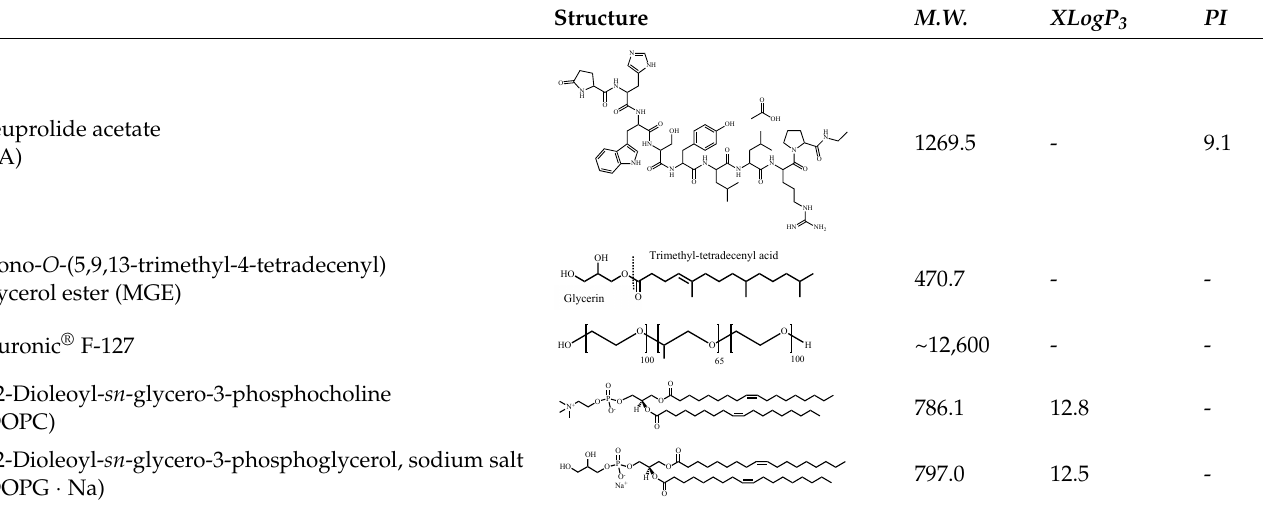
2.2. Methods 2.2. Methods 2.2.1. Preparation of Lipid Particles 2.2. Methods 2.2.1. Preparation of Lipid Particles DOPC and DOPG with a molar ratio of 25:75 at 1.0 mM total lipid concentration were 2.2. Methods 2.2.1. Preparation of Lipid Particles DOPC and DOPG with a molar ratio of 25:75 at 1.0 mM total lipid concentration were dissolved in ethanol in a flask, then evaporated at 50 °C to obtain a thin lipid layer. This 2.2.1. Preparation of Lipid Particles dissolved in ethanol in a flask, then evaporated at 50 °C to obtain a thin lipid layer. This ratio was chosen based on a preliminary study with different molar ratios of DOPC and DOPC and DOPG with a molar ratio of 25:75 at 1.0 mM total lipid concentration were DOPC and DOPG with a molar ratio of 25:75 at 1.0 mM total lipid concentration were ratio was chosen based on a preliminary study with different molar ratios of DOPC and DOPG (100:0, 75:25, 55: 45, 25:75) because it gave a small particle size with a small poly- dissolved in ethanol in a flask, then evaporated at 50 °C to obtain a thin lipid layer. This dissolved in ethanol in a flask, then evaporated at 50 °C to obtain a thin lipid layer. This DOPG (100:0, 75:25, 55: 45, 25:75) because it gave a small particle size with a small poly- dispersity index value (PDI) (Figure S1). Next, MGE: Pluronic ® F-127: DOPG was dis- ratio was chosen based on a preliminary study with different molar ratios of DOPC and DOPC and DOPG with a molar ratio of 25:75 at 1.0 mM total lipid concentration were ratio was chosen based on a preliminary study with different molar ratios of DOPC and DOPG (100:0, 75:25, 55: 45, 25:75) because it gave a small particle size with a small poly- dispersity index value (PDI) (Figure S1). Next, MGE: Pluronic ® F-127: DOPG was dis- solved in ethanol at a molar ratio of 1:1:1 at total lipid concentrations of 1.0, 5.0, and 10 mM. After evaporation of ethanol, LA solution, prepared by dissolving in pH 7.4 phos- phate-buffered saline (PBS) at 1.0 mg/mL concentration was added, followed by ultrasonic (VC-505, Sonics & Materials, Inc., Newtown, CT, USA) treatment for 30 s. This ultrasonic application process was repeated three times to obtain lipid suspensions. Finally, the lipid layer composed of DOPC and DOPG was hydrated with the lipid suspensions, followed by three ultrasonic treatments for 30 s each to obtain lipid formulations. As a comparison, LA-entrapping liposomes were prepared by hydration of a thin lipid layer composed of DOPC and DOPG at a molar ratio of 25:75 with 1.0 mg/mL of LA solution. In addition, a lipid formulation with Pluronic ® F-127: DOPG at a molar ratio 1:1, MGE-free formulation, was also prepared. Furthermore, an LA-free formulation (blank dispersity index value (PDI) (Figure S1). Next, MGE: Pluronic ® F-127: DOPG was dis- solved in ethanol at a molar ratio of 1:1:1 at total lipid concentrations of 1.0, 5.0, and 10 mM. After evaporation of ethanol, LA solution, prepared by dissolving in pH 7.4 phos- phate-buffered saline (PBS) at 1.0 mg/mL concentration was added, followed by ultrasonic (VC-505, Sonics & Materials, Inc., Newtown, CT, USA) treatment for 30 s. This ultrasonic application process was repeated three times to obtain lipid suspensions. Finally, the lipid layer composed of DOPC and DOPG was hydrated with the lipid suspensions, followed by three ultrasonic treatments for 30 s each to obtain lipid formulations. As a comparison, LA-entrapping liposomes were prepared by hydration of a thin lipid layer composed of DOPC and DOPG at a molar ratio of 25:75 with 1.0 mg/mL of LA solution. In addition, a lipid formulation with Pluronic ® F-127: DOPG at a molar ratio 1:1, MGE-free formulation, was also prepared. Furthermore, an LA-free formulation (blank solved in ethanol at a molar ratio of 1:1:1 at total lipid concentrations of 1.0, 5.0, and 10 mM. After evaporation of ethanol, LA solution, prepared by dissolving in pH 7.4 phos- phate-buffered saline (PBS) at 1.0 mg/mL concentration was added, followed by ultrasonic (VC-505, Sonics & Materials, Inc., Newtown, CT, USA) treatment for 30 s. This ultrasonic application process was repeated three times to obtain lipid suspensions. Finally, the lipid layer composed of DOPC and DOPG was hydrated with the lipid suspensions, followed by three ultrasonic treatments for 30 s each to obtain lipid formulations. As a comparison, LA-entrapping liposomes were prepared by hydration of a thin lipid layer composed of DOPC and DOPG at a molar ratio of 25:75 with 1.0 mg/mL of LA solution. In addition, a lipid formulation with Pluronic ® F-127: DOPG at a molar ratio 1:1, MGE-free formulation, was also prepared. Furthermore, an LA-free formulation DOPG (100:0, 75:25, 55: 45, 25:75) because it gave a small particle size with a small poly- dispersity index value (PDI) (Figure S1). Next, MGE: Pluronic ® F-127: DOPG was dis- solved in ethanol at a molar ratio of 1:1:1 at total lipid concentrations of 1.0, 5.0, and 10 mM. After evaporation of ethanol, LA solution, prepared by dissolving in pH 7.4 phos- phate-buffered saline (PBS) at 1.0 mg/mL concentration was added, followed by ultrasonic (VC-505, Sonics & Materials, Inc., Newtown, CT, USA) treatment for 30 s. This ultrasonic application process was repeated three times to obtain lipid suspensions. Finally, the lipid layer composed of DOPC and DOPG was hydrated with the lipid suspensions, followed by three ultrasonic treatments for 30 s each to obtain lipid formulations. As a comparison, LA-entrapping liposomes were prepared by hydration of a thin lipid layer composed of DOPC and DOPG at a molar ratio of 25:75 with 1.0 mg/mL of LA solution. In addition, a lipid formulation with Pluronic ® F-127: DOPG at a molar ratio 1:1, MGE-free formulation, was also prepared. Furthermore, an LA-free formulation (blank dissolved in ethanol in a flask, then evaporated at 50 °C to obtain a thin lipid layer. This ratio was chosen based on a preliminary study with different molar ratios of DOPC and DOPG (100:0, 75:25, 55: 45, 25:75) because it gave a small particle size with a small poly- dispersity index value (PDI) (Figure S1). Next, MGE: Pluronic ® F-127: DOPG was dis- solved in ethanol at a molar ratio of 1:1:1 at total lipid concentrations of 1.0, 5.0, and 10 mM. After evaporation of ethanol, LA solution, prepared by dissolving in pH 7.4 phos- phate-buffered saline (PBS) at 1.0 mg/mL concentration was added, followed by ultrasonic (VC-505, Sonics & Materials, Inc., Newtown, CT, USA) treatment for 30 s. This ultrasonic application process was repeated three times to obtain lipid suspensions. Finally, the lipid layer composed of DOPC and DOPG was hydrated with the lipid suspensions, followed by three ultrasonic treatments for 30 s each to obtain lipid formulations. As a comparison, LA-entrapping liposomes were prepared by hydration of a thin lipid layer composed of DOPC and DOPG at a molar ratio of 25:75 with 1.0 mg/mL of LA solution. In addition, a lipid formulation with Pluronic ® F-127: DOPG at a molar ratio 1:1, MGE-free formulation, was also prepared. Furthermore, an LA-free formulation (blank